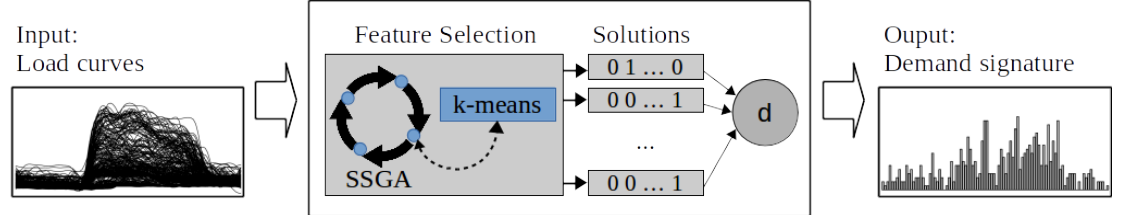
Figure 2. Electricity demand signature